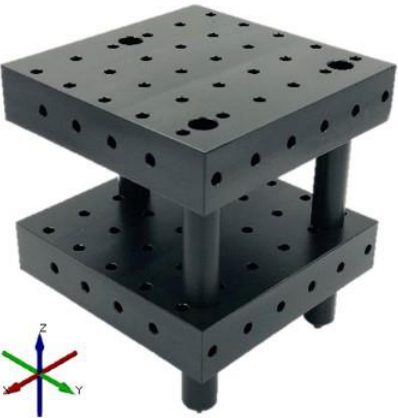
Figure 3. The quality assurance Phantom for examining the MSCT imaging error.